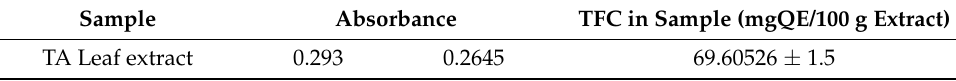
Table 5. Total Flavonoid Contents (TFC).